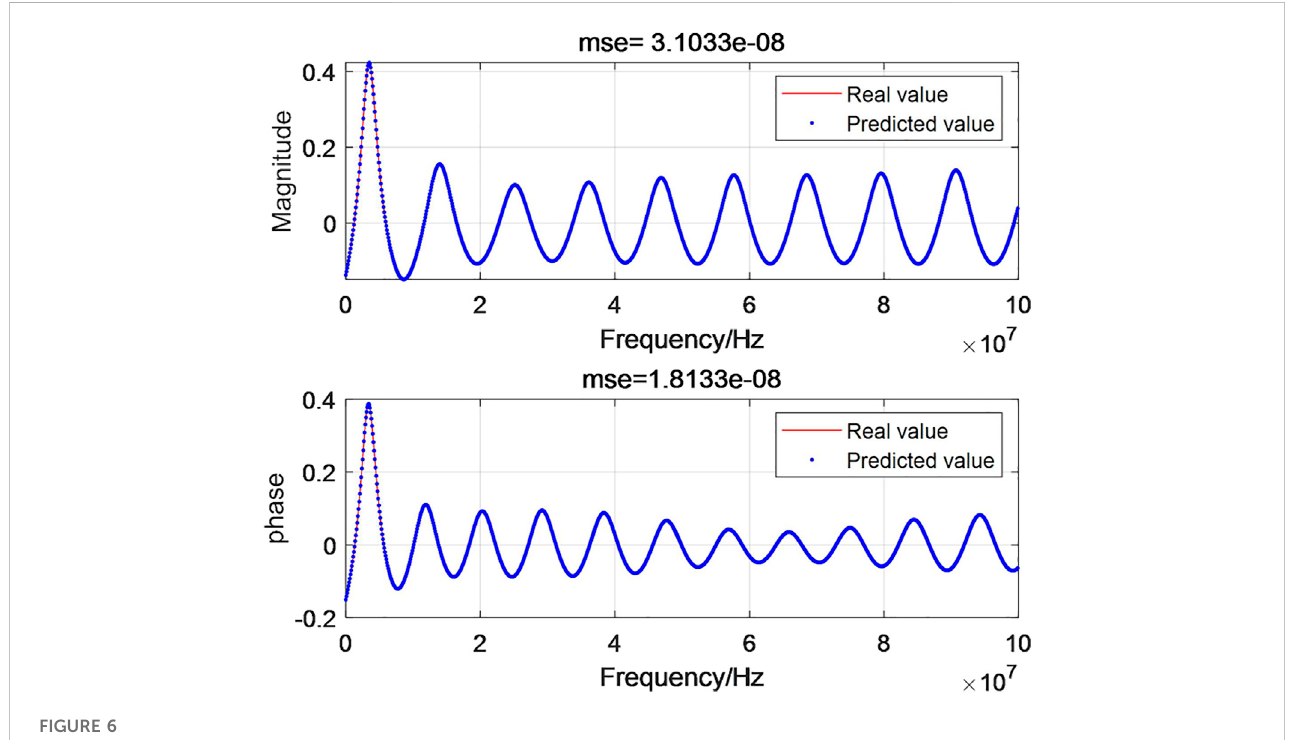
FIGURE 6 Predicted results of impedance estimation.